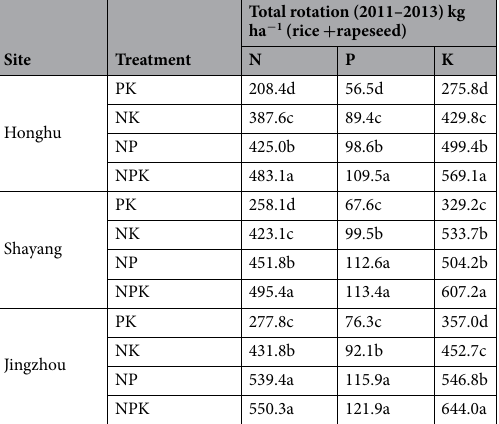
Table 3. Total N, P, and K uptake (kg ha − 1 ) by aboveground part of rice and oilseed rape together in different sites of Hubei province affected by fertilization. Mean values within a column for each season followed by different letters are significantly different at P < 0.05 according to LSD.